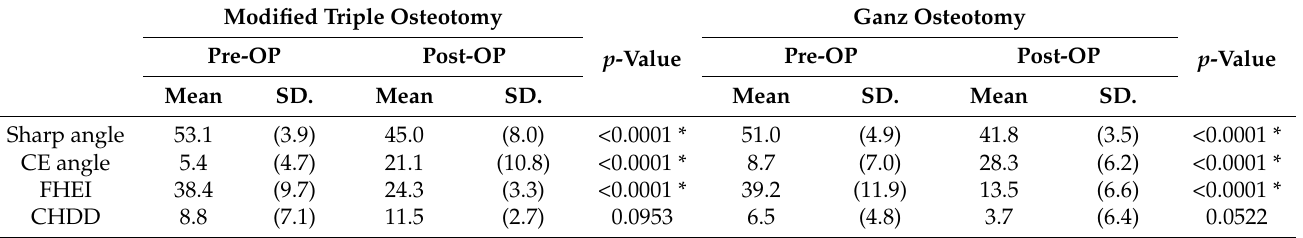
Table 2. Comparison of Preoperative and Post-Operative Radiographic Parameters Using Paired T-Test in The Modified Triple Osteotomy Group and Ganz Osteotomy Group.